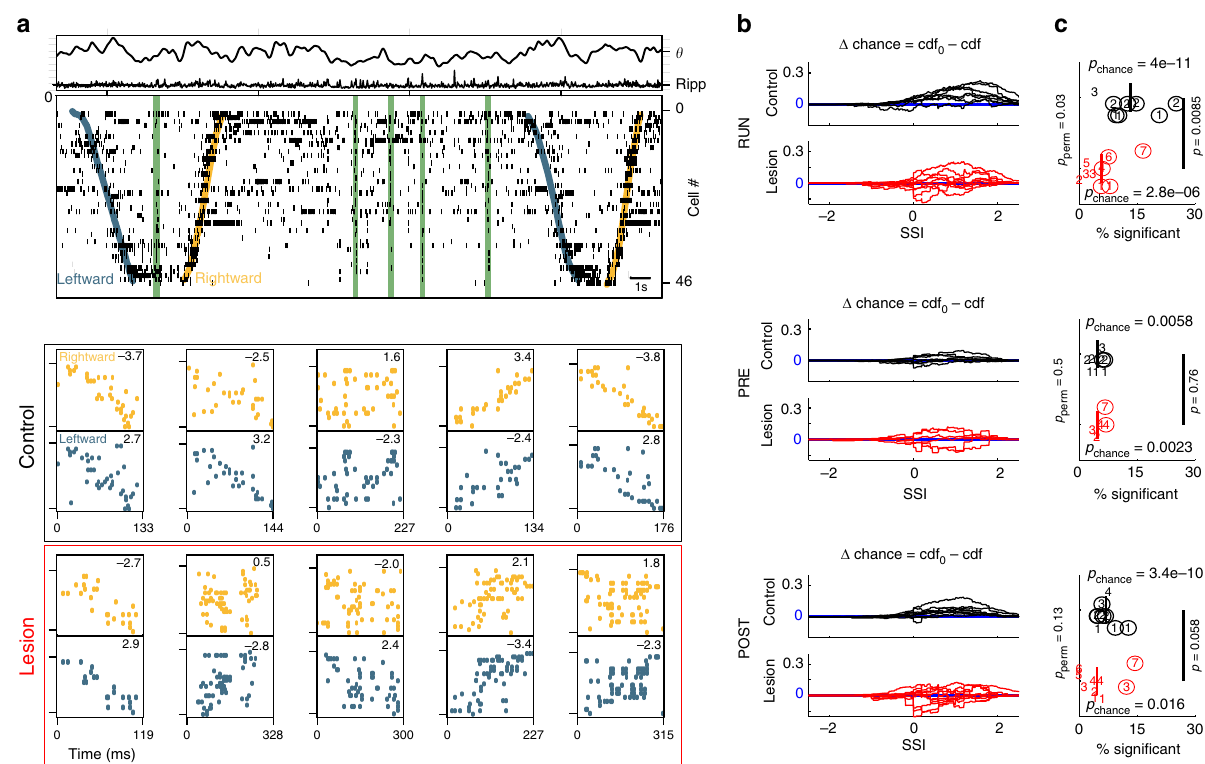
Fig. 2 Spatial sequences. a Top: Example data from a RUN epoch of a control animal. Top: LFP theta and ripple power (in a.u.). Bottom: Spike raster plot where cells are ordered according to their place fi eld centers on rightward runs (yellow) and leftward runs (blue). Green bars indicate place cell bursts. Bottom: Examples of zoomed in place cell bursts for rightward (top, spikes in yellow) and leftward (bottom, spikes in blue) runs. Numbers are respective SSIs. Black box: examples from the control group; Red box: examples from the MEC-lesion group. b Excess cumulative SSI probabilities [difference between cumulative SSI distributions from the shuf fl ed data (cdf0) and the actual data (cdf)] for all sessions in control (black) and MEC-lesioned (red) animals under the three recording conditions (RUN, PRE, and POST). Positive cdf0 – cdf indicates a rightward shift of cdf, i.e., larger real than shuf fl ed SSIs. c Epoch- wise percentages of signi fi cant SSIs. Each epoch is depicted by one numeric symbol. Different numbers encode animal identity (control: 1 – 4, MEC-lesion: 1 – 7). Numbers in circle indicate signi fi cant epochs. p chance : p value of binomial test on the number of signi fi cant sessions given the expectation from